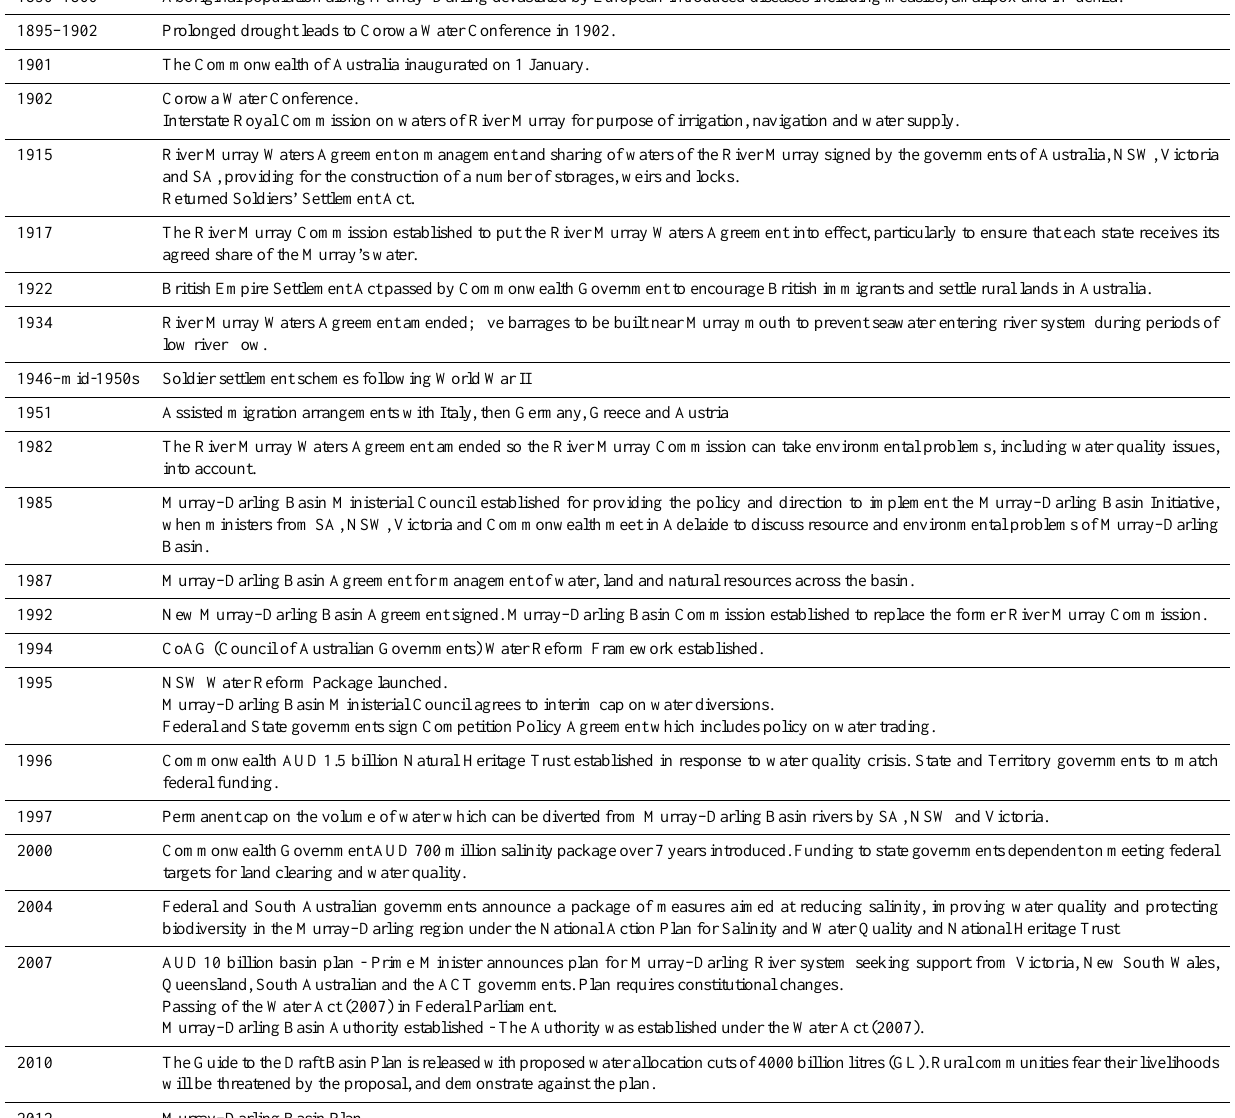
Table 1. Summary timeline of major policies and initiatives in the Murray–Darling Basin, State Library of South Australia